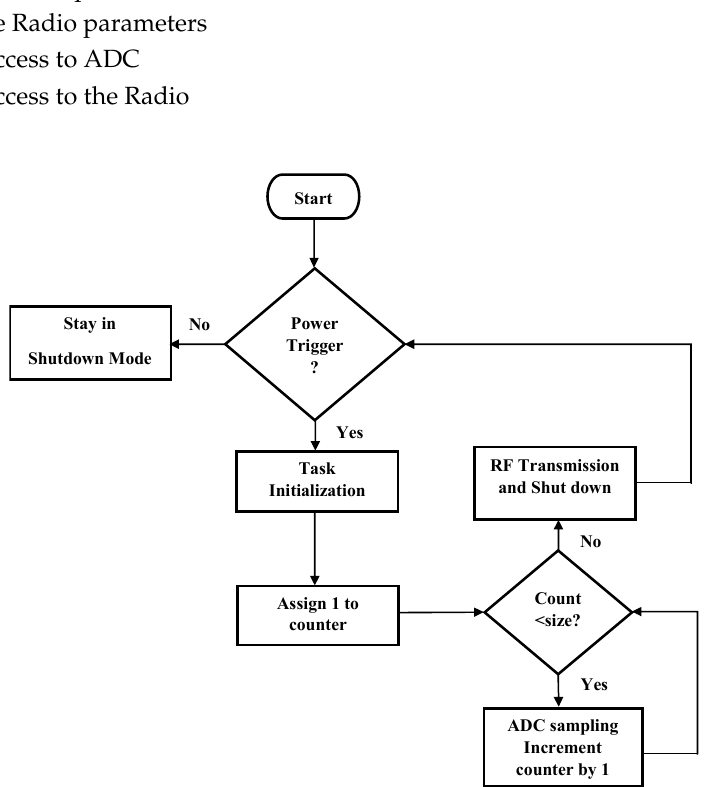
Figure 8 . Wireless MCU process flow chart. Algorithm used to operate the Wireless MCU designed for controlling the wireless sensor node’s operation.